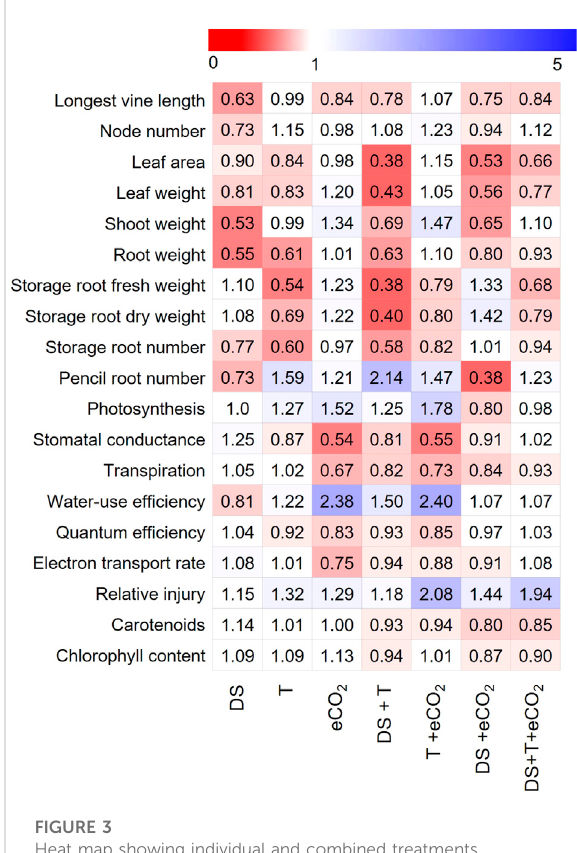
FIGURE 3 Heat map showing individual and combined treatments induced responses of vegetative, physiological, and photosynthetic parameters relative to control treatment. Each column represents a phenotypic response (average of three cultivars) relative to control (Supplementary Table S3), and each row represents the overall parameter response to treatment. The color codes depict the parameter range for each treatment, with “ red ” indicating alowervalue( < 1,decreasedcomparedtocontrol), whereas “ blue ” indicatesahighervalue( > 1,increasedcomparedto control) for a given parameter. Parameter acronyms and units are given in Table